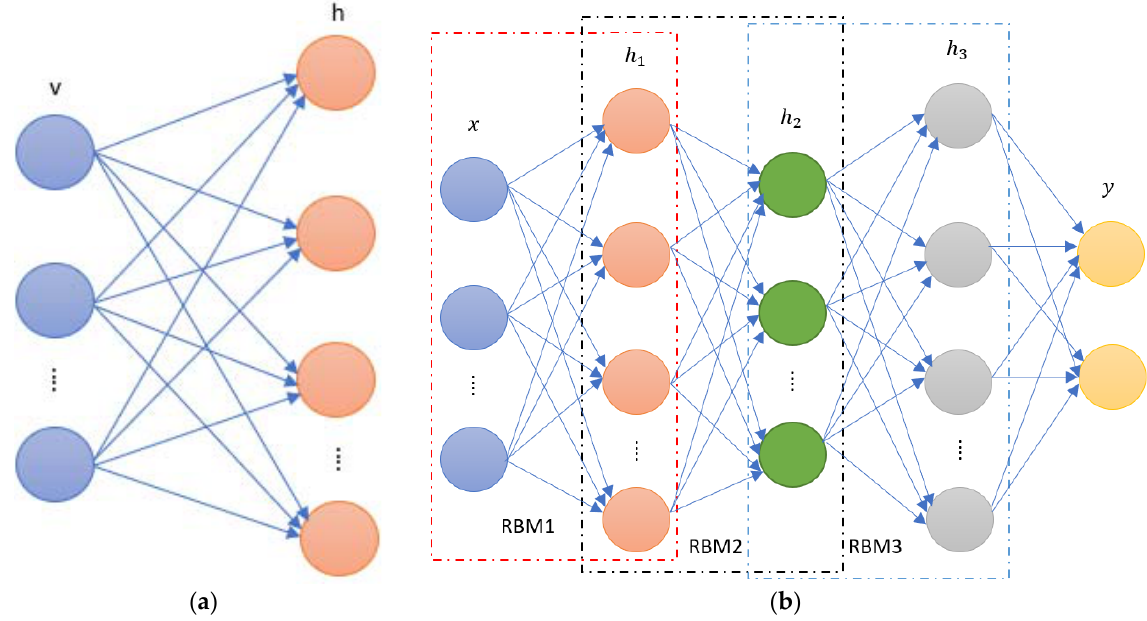
Figure 5. ( a ) Restricted Boltzmann machines; ( b ) Structure of RBM ‐ based deep belief network.